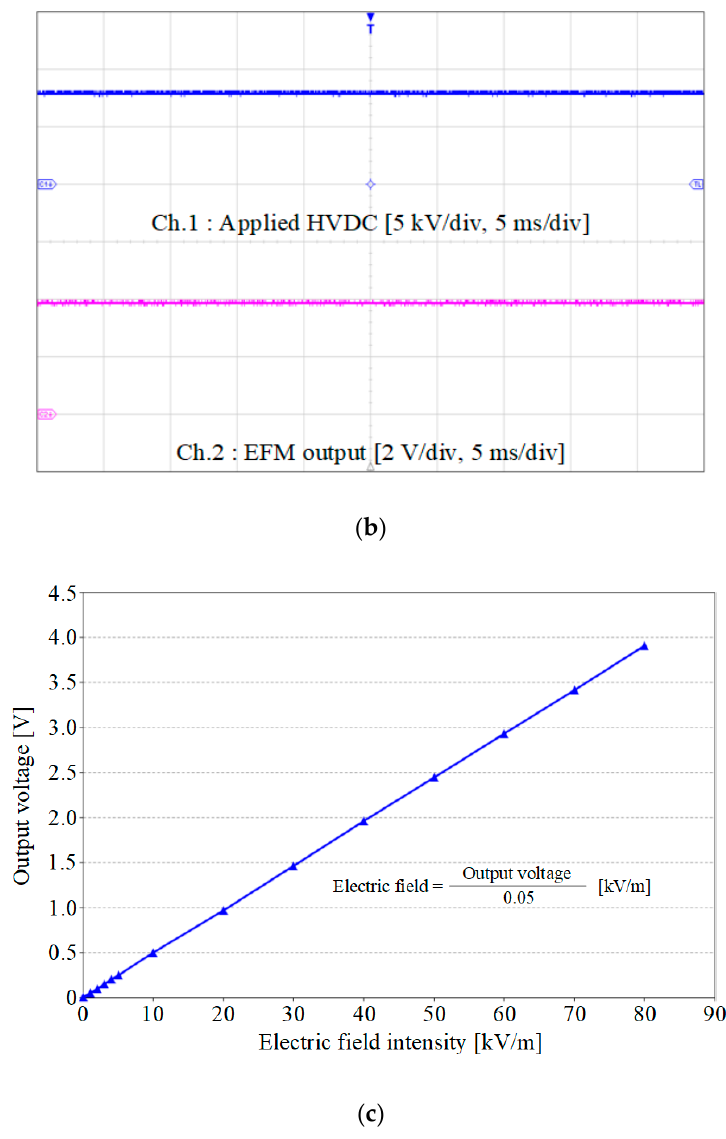
Figure 3. Calibration of EFM sensor. ( a ) Experimental setup; ( b ) output signals; ( c ) result.